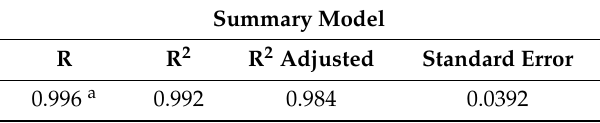
Table 16. Determination coefficients: Wheel-tracking test and relation between second and first moduli of the plate bearing test (Ev 2 /Ev 1 ).